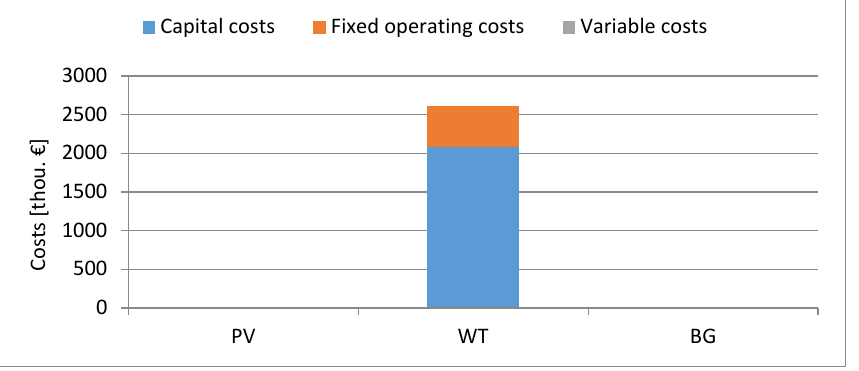
Figure 4. The cost structure for scenario “3”.